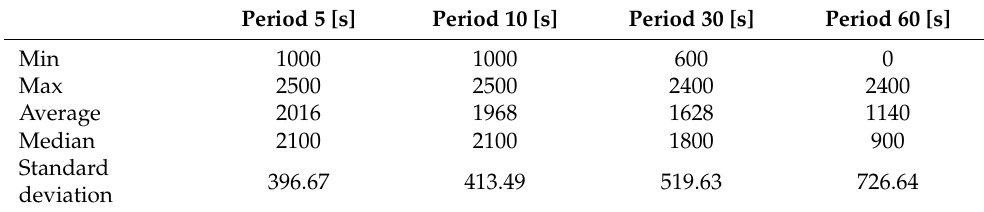
Table 4. Resulting distances [m] at the time of detection of two trains on an identical edge. Period 5 [s]